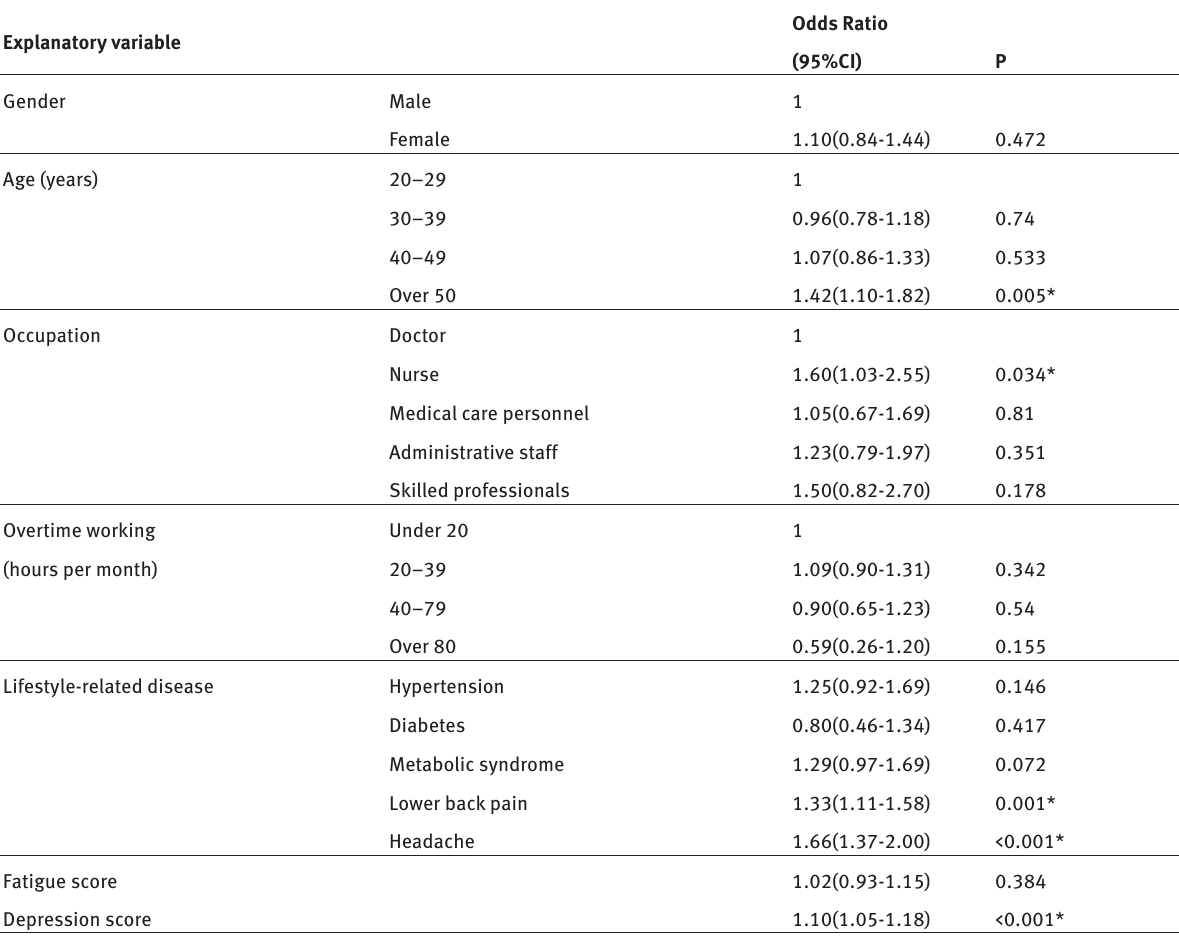
Table 2: Logistic regression analysis regarding factors associated with chronic insomnia